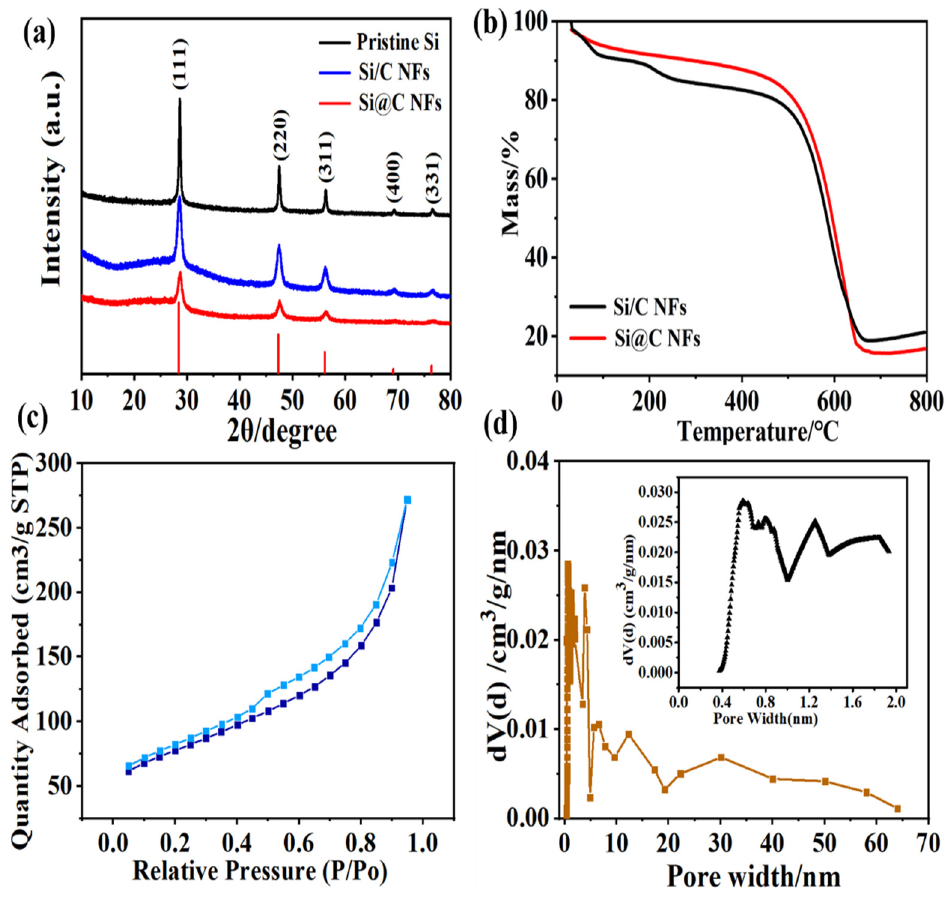
Figure 2. ( a ) XRD patterns of pristine Si NPs, Si@C NFs and Si/C NFs; ( b ) TG curves of Si@C NFs and Si/C NFs at a heating rate of 10 °C min − 1 in N 2 . ( c ) The N 2 adsorption/desorption isotherm and and Si/C NFs at a heating rate of 10 ◦ C min − 1 in N 2 . ( c ) The N 2 adsorption/desorption isotherm ( d ) pore size distribution of Si@C NFs. and ( d ) pore size distribution of Si@C